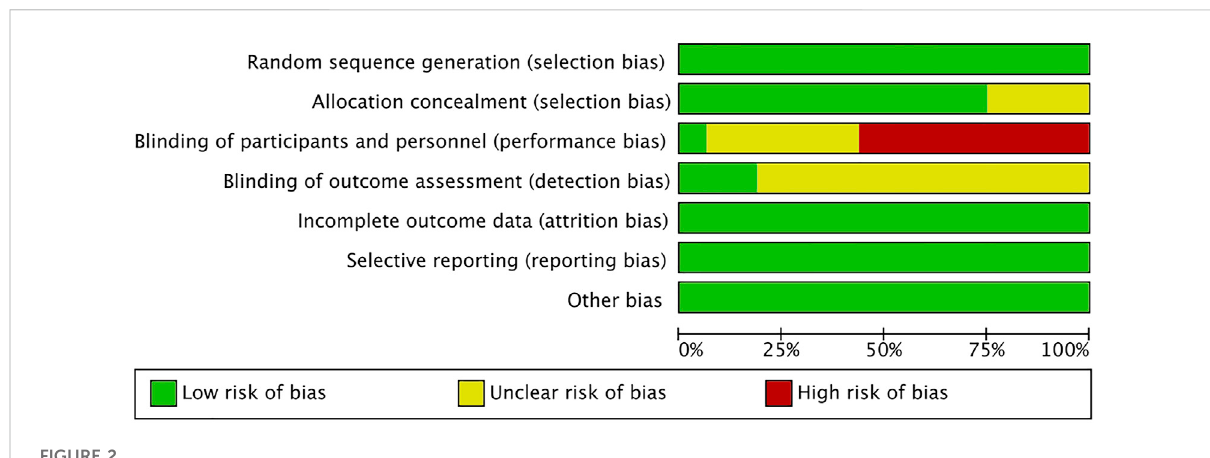
FIGURE 2 Risk of bias graph of included